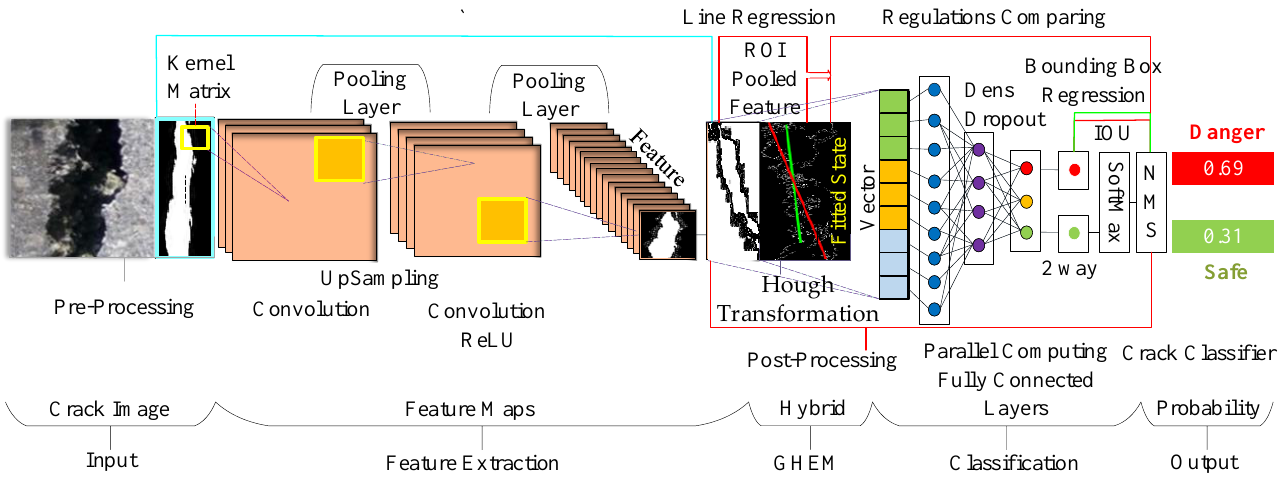
Figure 5. The GHEM Fast R-CNN automatic crack evaluation system architecture with deformation design suitable for this study.